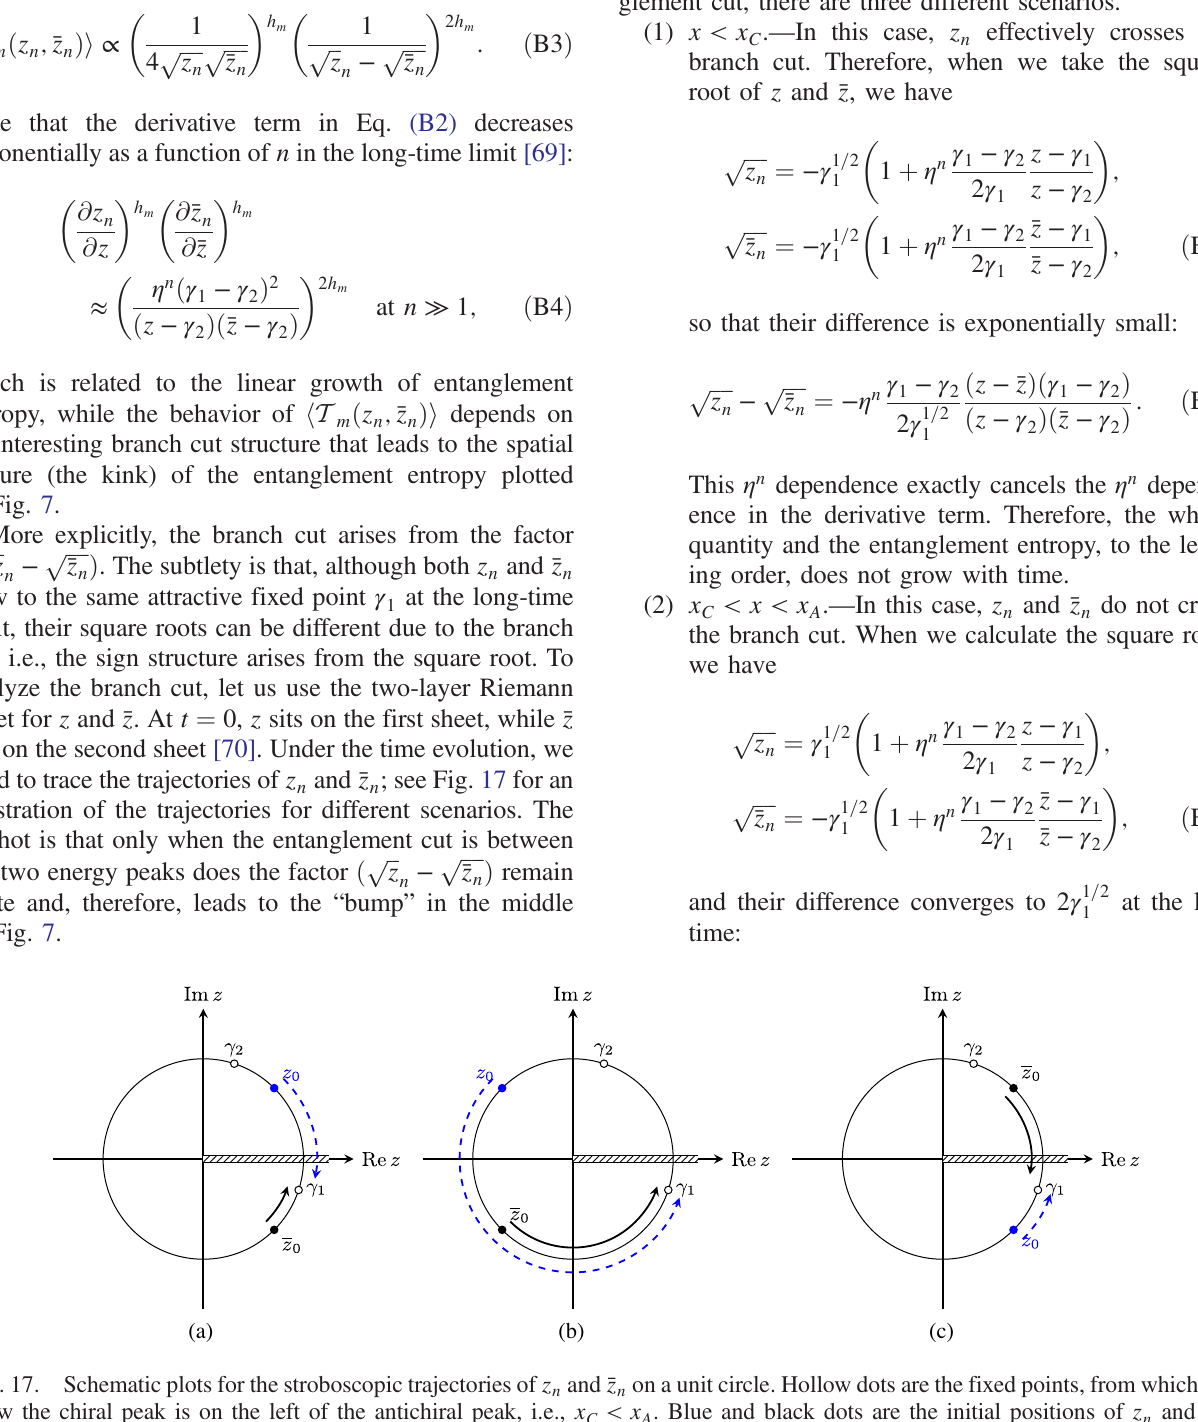
FIG. 17. Schematic plots for the stroboscopic trajectories of z know the chiral peak is on the left of the antichiral peak, i.e., x respectively. In each cycle, both z their stroboscopic positions represented by the blue dashed line and black line, respectively. The dashed bar denotes the branch cut. (a) x < x . The blue line crosses the branch cut, meaning that z C Riemann sheet in the long-time limit. (b) x (c) x > x . This time, it is the black line that crosses the branch cut; thus, z A